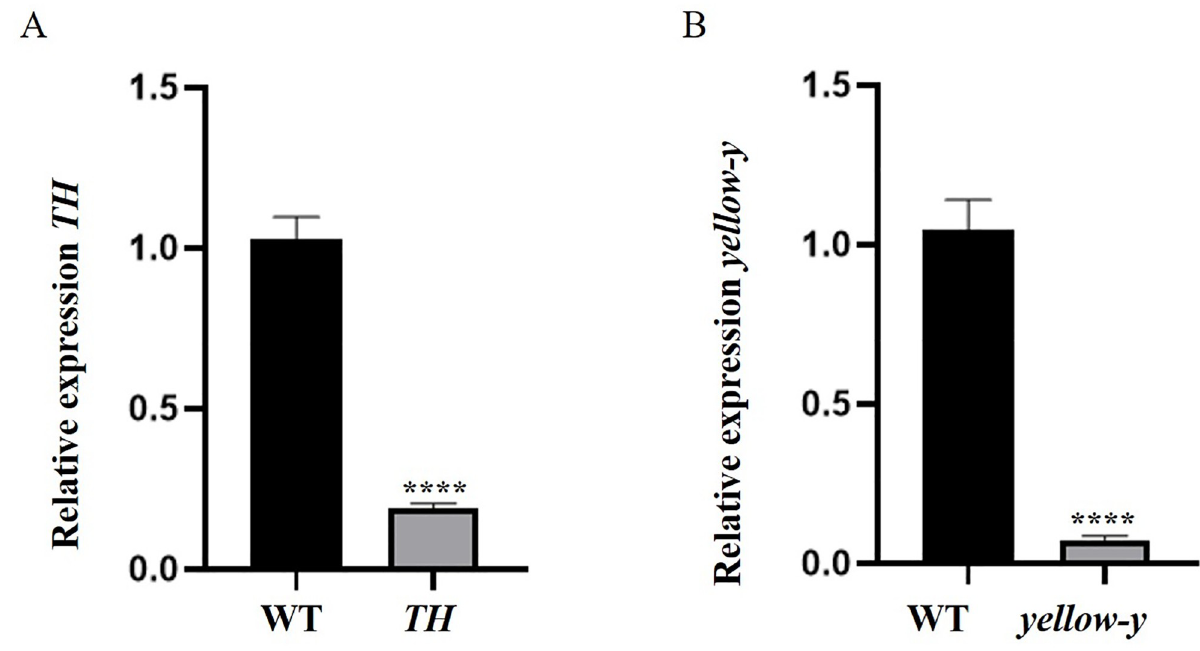
Fig 4. The relative mRNA expression in WT and mutants. (A) Decreased mRNA level of TH was detected in TH mutants. P < 0.0001. ( t = 11.9, df = 22) (B) Decreased mRNA level of yellow-y was detected in yellow-y mutants. P < 0.0001. ( t = 10.40, df = 22) The mRNA levels were normalized to beta-actin. The mean of the relative expression of the WT is set to 1. The error bars represent the mean ± SE. Asterisks represent statistically significant